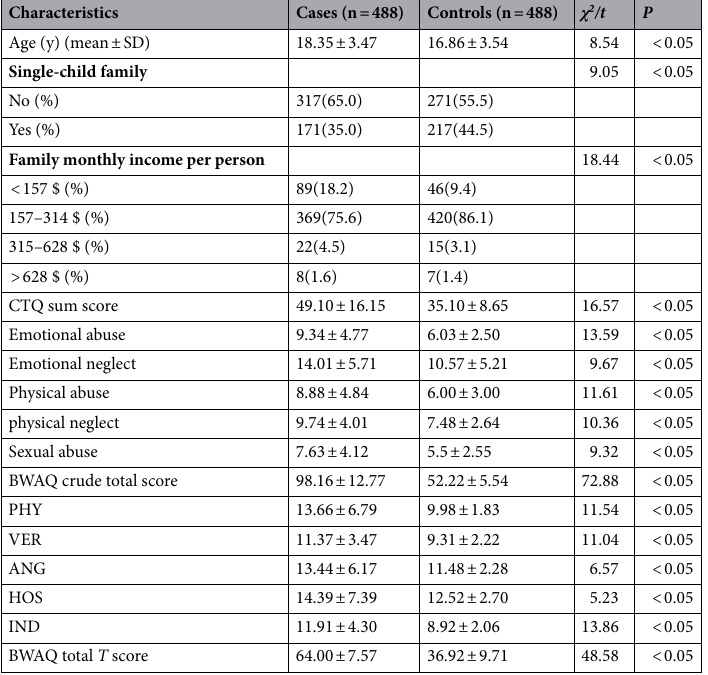
Table 1. Baseline characteristics of participants in the current case–control study. Variables are presented as mean ± SD for numerical data and number (%) for categorical data. CTQ Childhood Trauma Questionnaire, BWAQ Buss and Warren’s Aggression Questionnaire, y years, PHY physical aggression, VER verbal aggression, ANG anger, HOS hostility, IND indirect aggression.